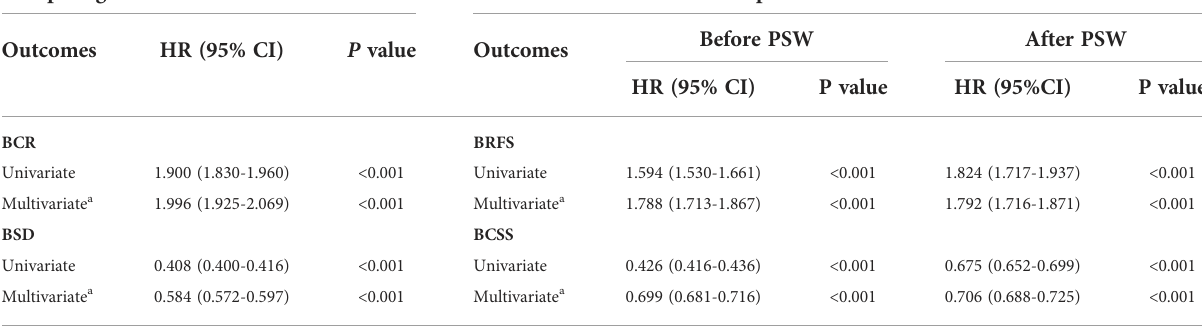
TABLE 3 Risk of breast cancer recurrence (BCR) and breast cancer-speci fi c death (BSD) and risk of breast cancer recurrence free survival (BRFS) and breast cancer-speci fi c survival without recurrence (BCSS). Competing Risk